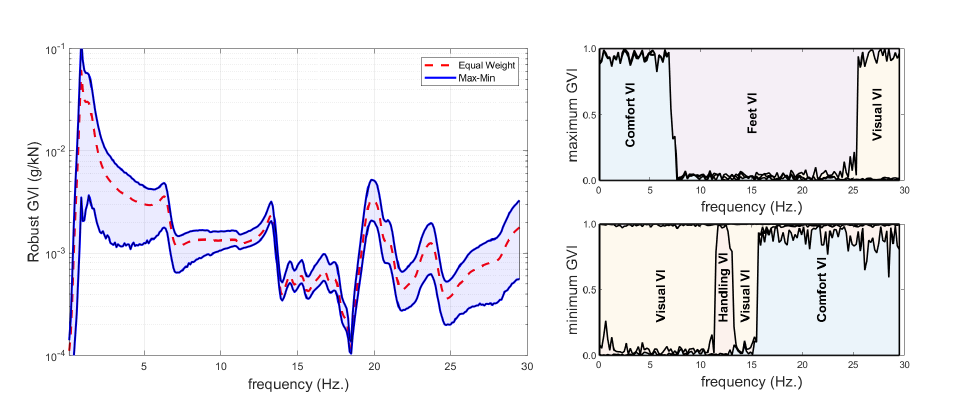
Figure 10. Robust generalized vibration index using different weights on comfort, handling, visual, and feet vibration